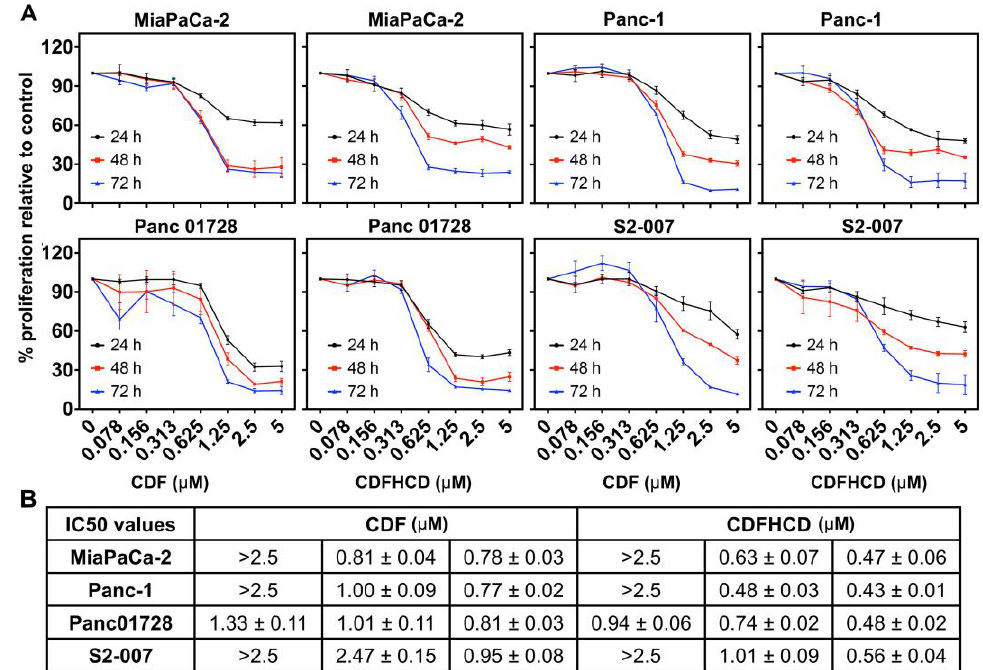
Figure 3. CDF and CDFHCD inhibit the proliferation of PDAC cell lines. ( A ). PDAC cells (MiaPaCa-2, Panc-1, Panc01728, and S2-007) were treated with increasing concentrations of CDF and CDFHCD (0–5 µ M) for up to 72h and studied using hexosaminidase assay. ( B ). The IC 50 values of the antiprolif- erative activity are summarized in the tabular format as mean ±